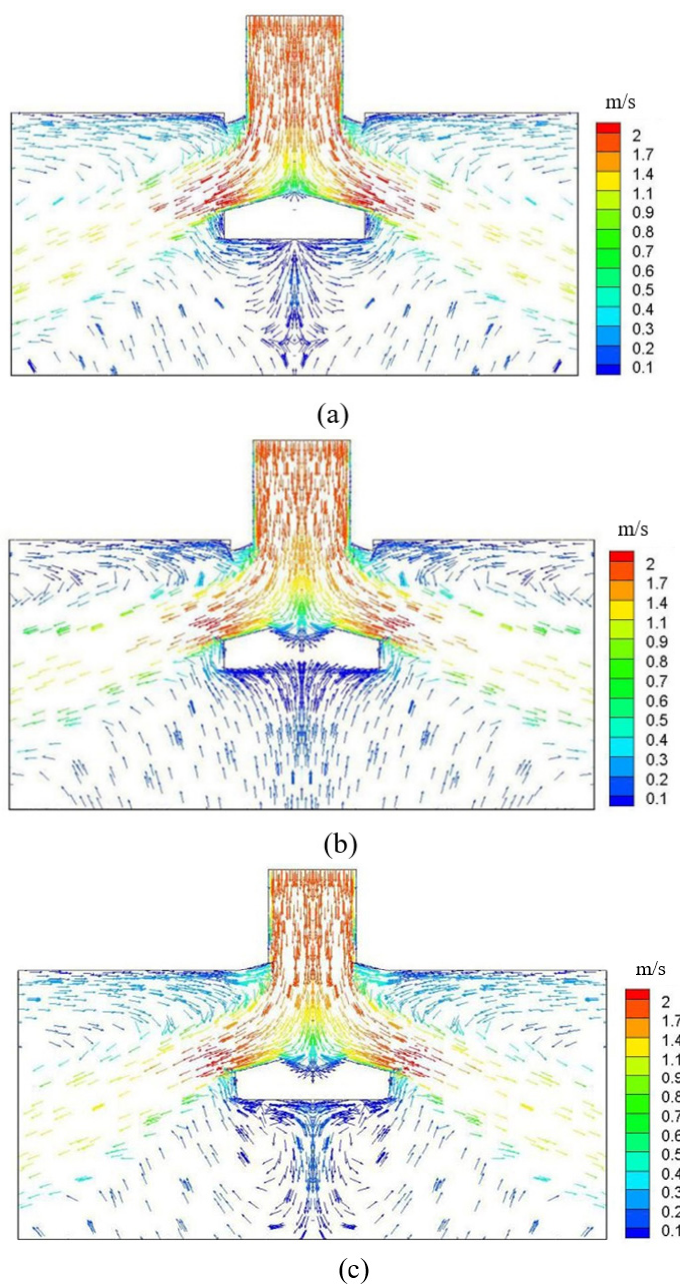
Figure 3. Local amplification of the velocity vector with different ( a ) SEN A, ( b ) SEN B and ( c ) SEN C.